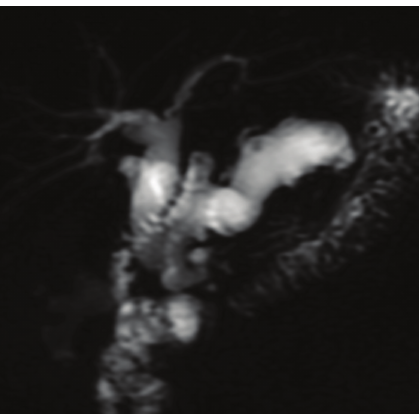
Figure 3: MD-IPMN with di ff usely dilated main pancreatic duct on MRCP (magnetic resonance cholangiopancreatography).